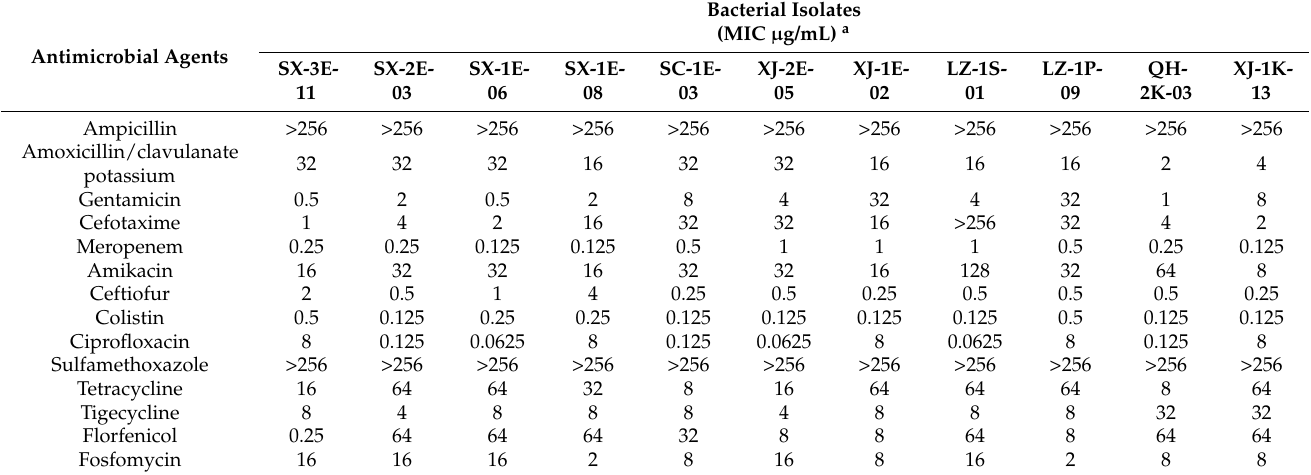
Table 2. Resistance pattern of tigecycline-resistant isolates against selected antimicrobial agents.